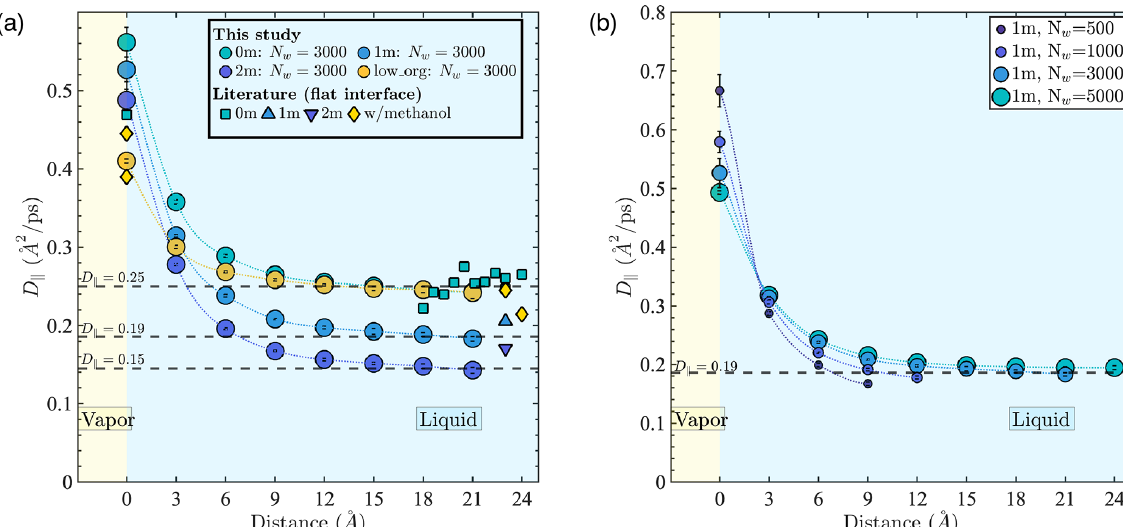
Figure 3. Water diffusion coefficient in the direction parallel to the interface ( D (cid:107) ) as a function of distance from the time-averaged interface (com scheme) (a) in 5.5nm droplets ( N w = 3000) with different aqueous chemistries and (b) in 1m NaCl droplets with different water contents (symbol sizes are scaled with droplet diameter). Literature data shown in panel (a) were collected from previous MD simulation studies using the SPC/E water model at 0m (Kim et al., 2012; Paul and Chandra, 2005; Tsimpanogiannis et al., 2019) and 1 and 2m (Kim et al., 2012) and for a methanol–water solution at low organic concentrations (Paul and Chandra, 2005). All literature D (cid:107) values were obtained for systems with a flat water–air